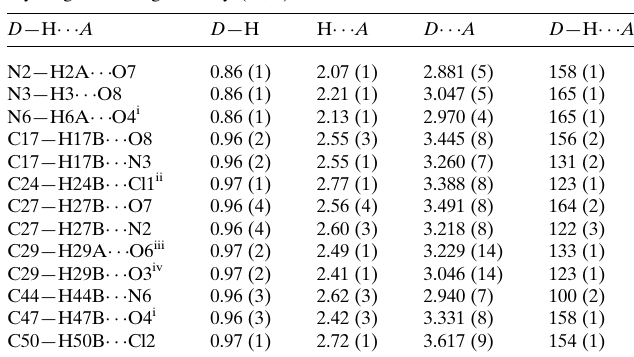
Table 1 Hydrogen-bond geometry (A˚ , (cid:3) ).